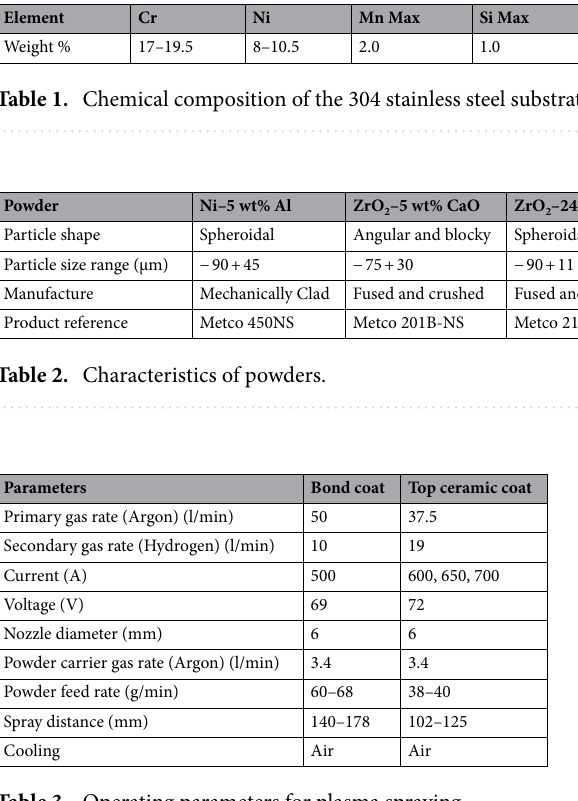
Table 3. Operating parameters for plasma spraying.